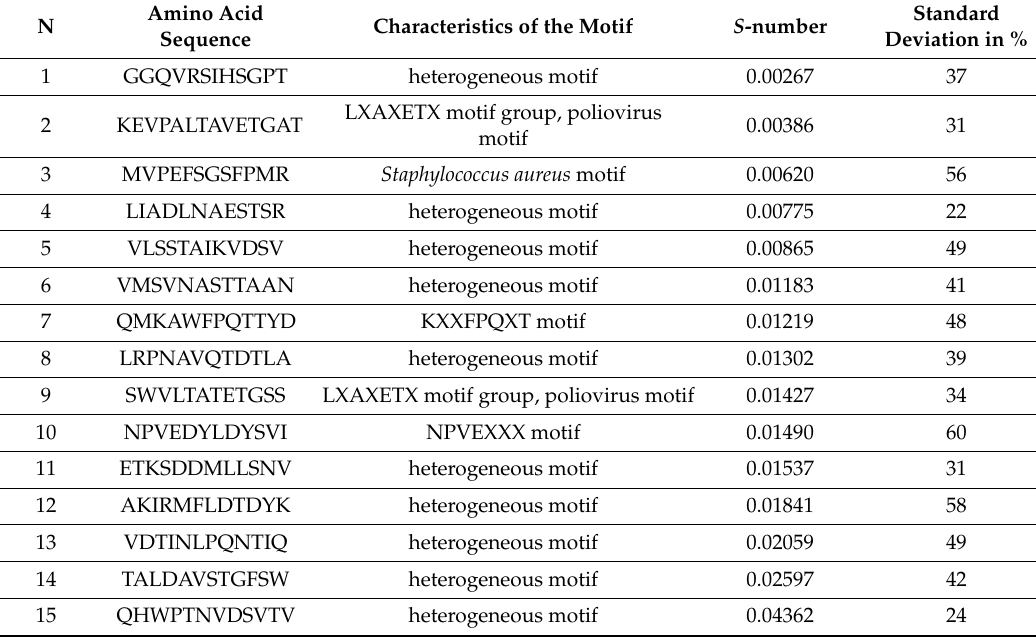
Table 1. Peptides corresponding to the binding motifs and their measured S